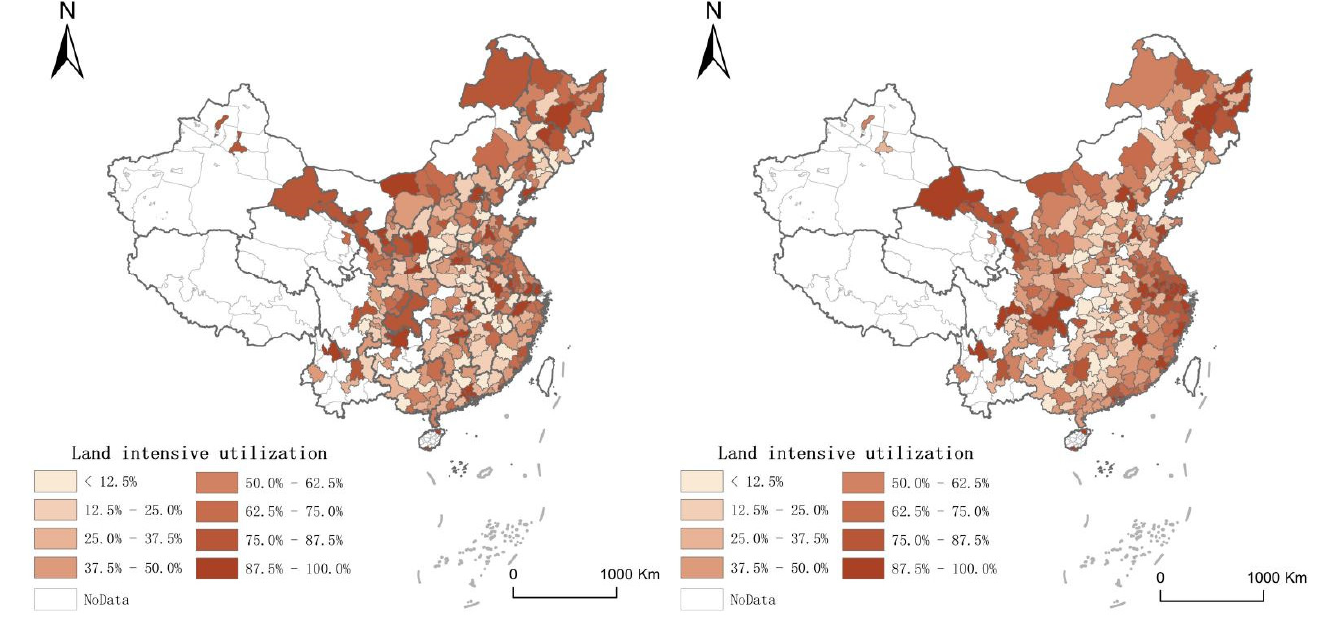
Figure 2. The distribution of land intensive use of China in 2009 and 2018.